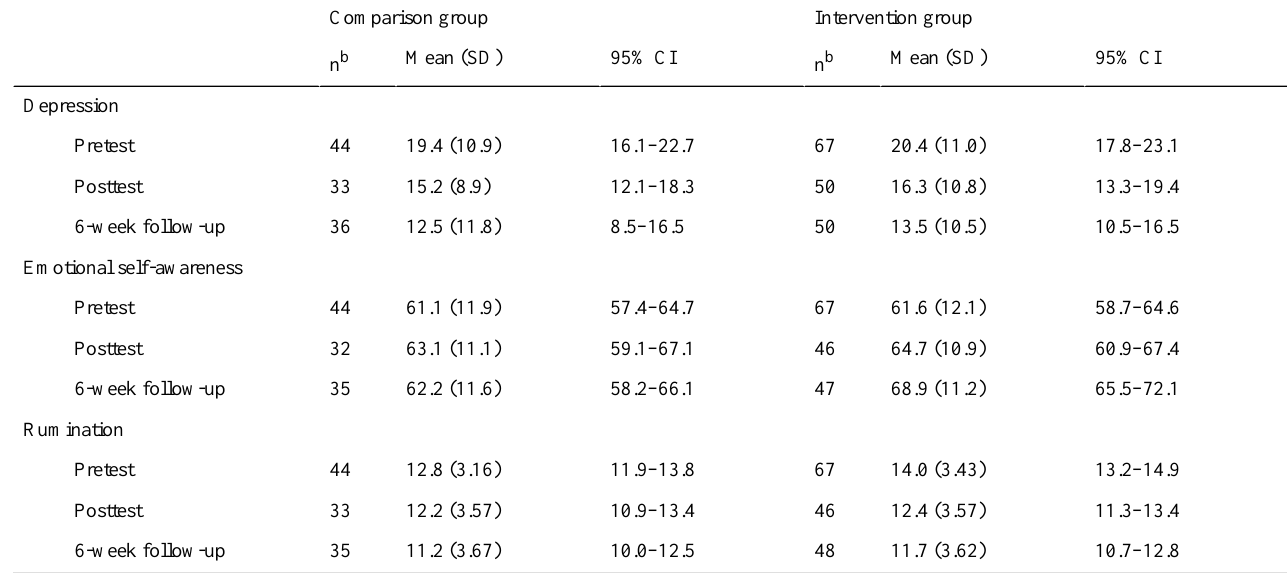
Table 3. Descriptive statistics for the intervention and comparison groups’scores a on depression and emotional self-awareness at pretest, posttest, and 6-week